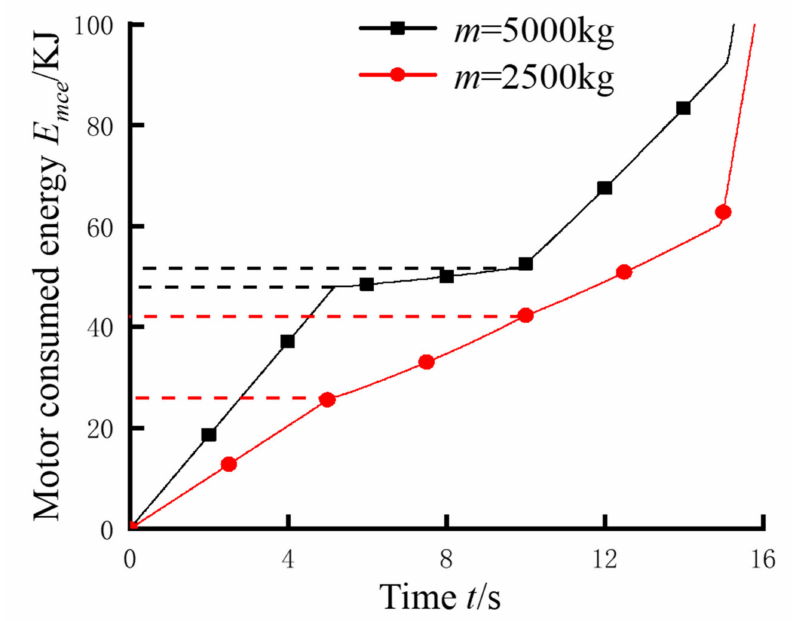
Figure 17. Motor energy consumption under different equivalent load mass m